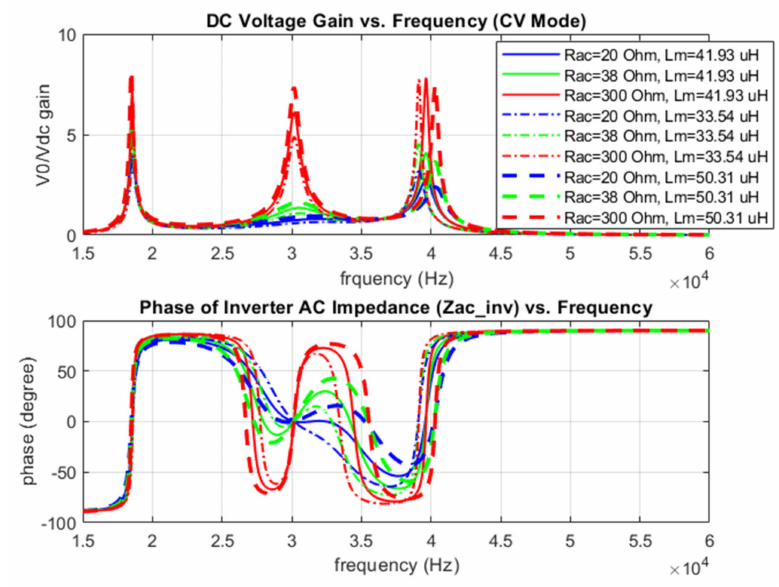
Figure 7. DC voltage gain vs. inverter power factor angle with respect to DAB switching frequency